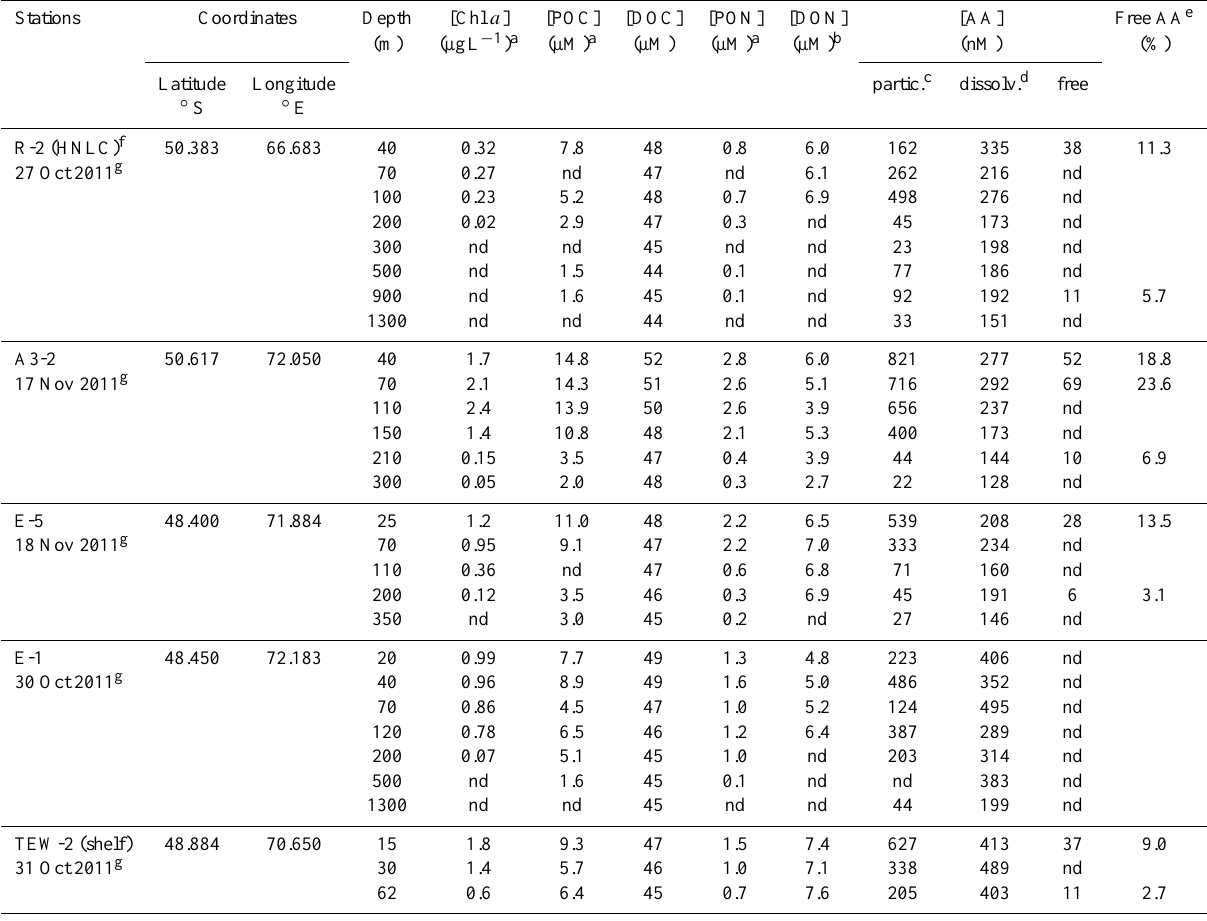
Table 1. Sampling sites, chlorophyll a (Chl a ) concentrations, particulate and dissolved organic carbon (POC, DOC) and nitrogen (PON, DON) concentrations, and amino acid (AA) concentrations in particulate and dissolved (including free AA) phases.